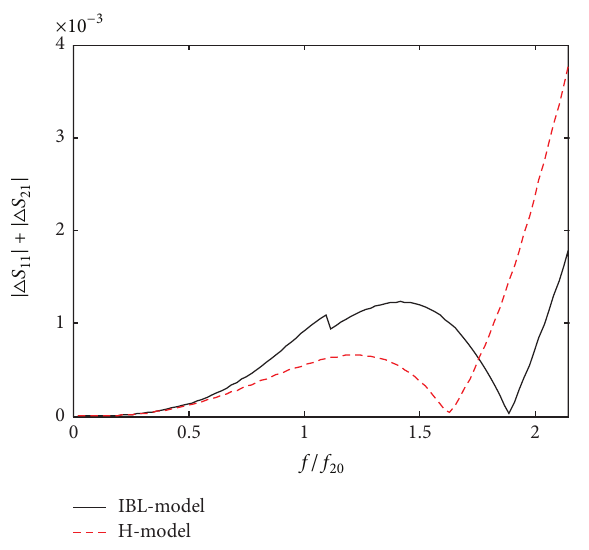
Figure 6: The 𝑆 -parameter differences at 𝜃 0 = 0 ∘ for the H- and IBL-models with parameters retrieved at normal incidence.